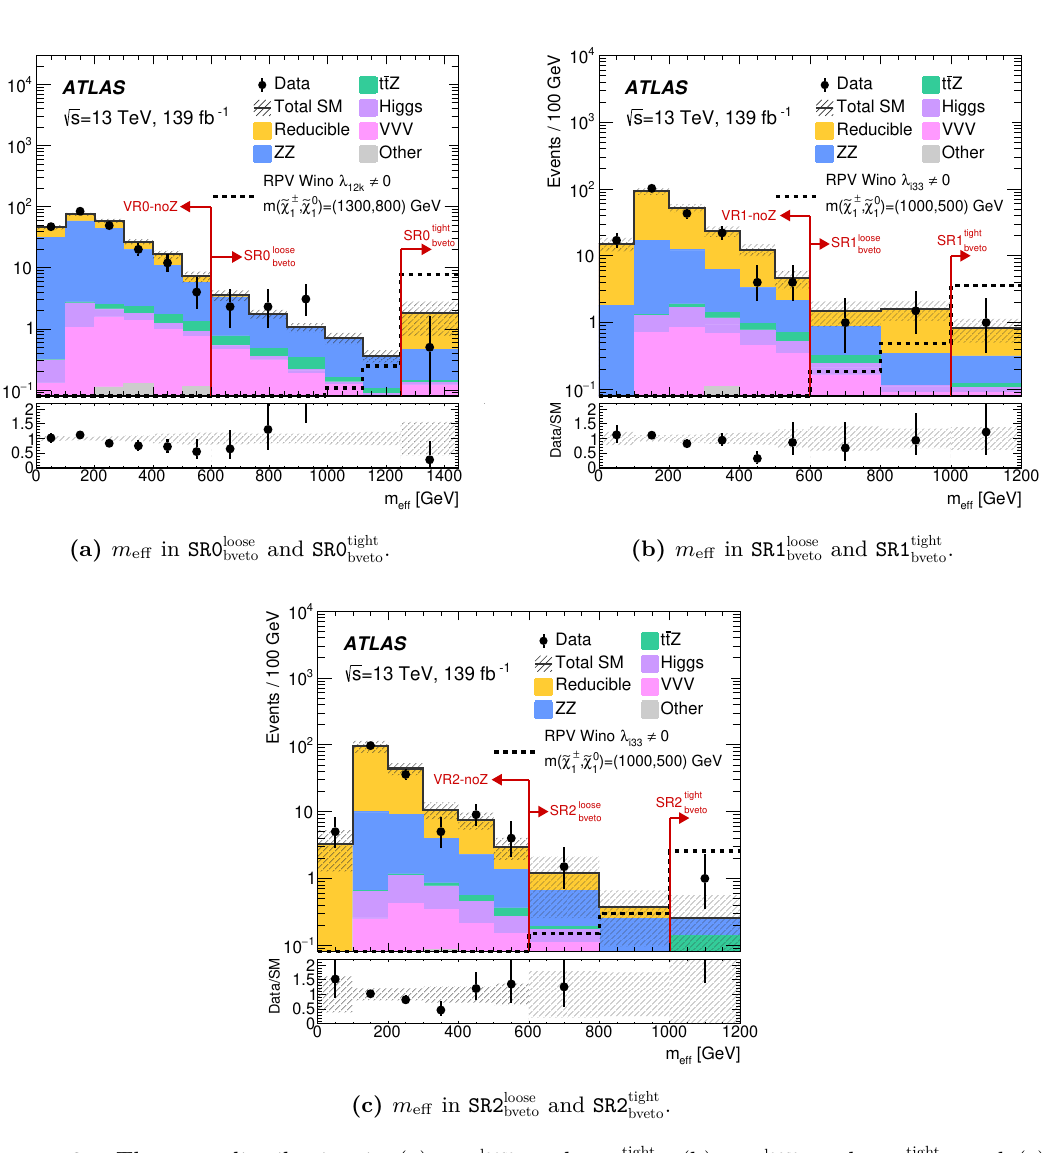
and SR0 tight , (b) SR1 loose and SR1 tight , and (c) Figure 9. The m eff distribution in (a) SR0 loose bveto bveto bveto bveto SR2 loose bveto and SR2 tight bveto for events passing the signal region requirements except the m eff requirement. Distributions for data, the estimated SM backgrounds after the background-only fit, and an example SUSY scenario are shown. “Other” is the sum of the tWZ , t ¯ tWW , t ¯ tZZ , t ¯ tWZ , t ¯ tWH , t ¯ tHH , t ¯ ttW , and t ¯ tt ¯ t backgrounds. The last bin captures the overflow events. The lower panel shows the ratio of the observed data to the expected SM background yield in each bin. Both the statistical and systematic uncertainties in the SM background are included in the shaded band. The red arrows indicate the m selections in the signal and validation eff